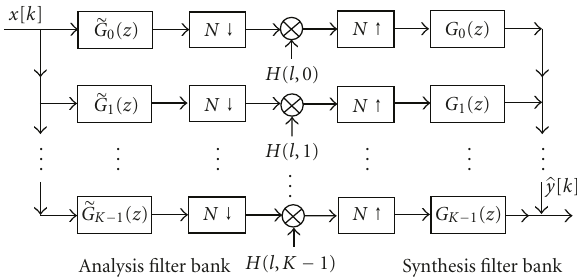
Figure 2: TF domain channel diagonalization with G k ( z ) (cid:2) G ( ze j 2 πk/K ), k = 0, ... , K −